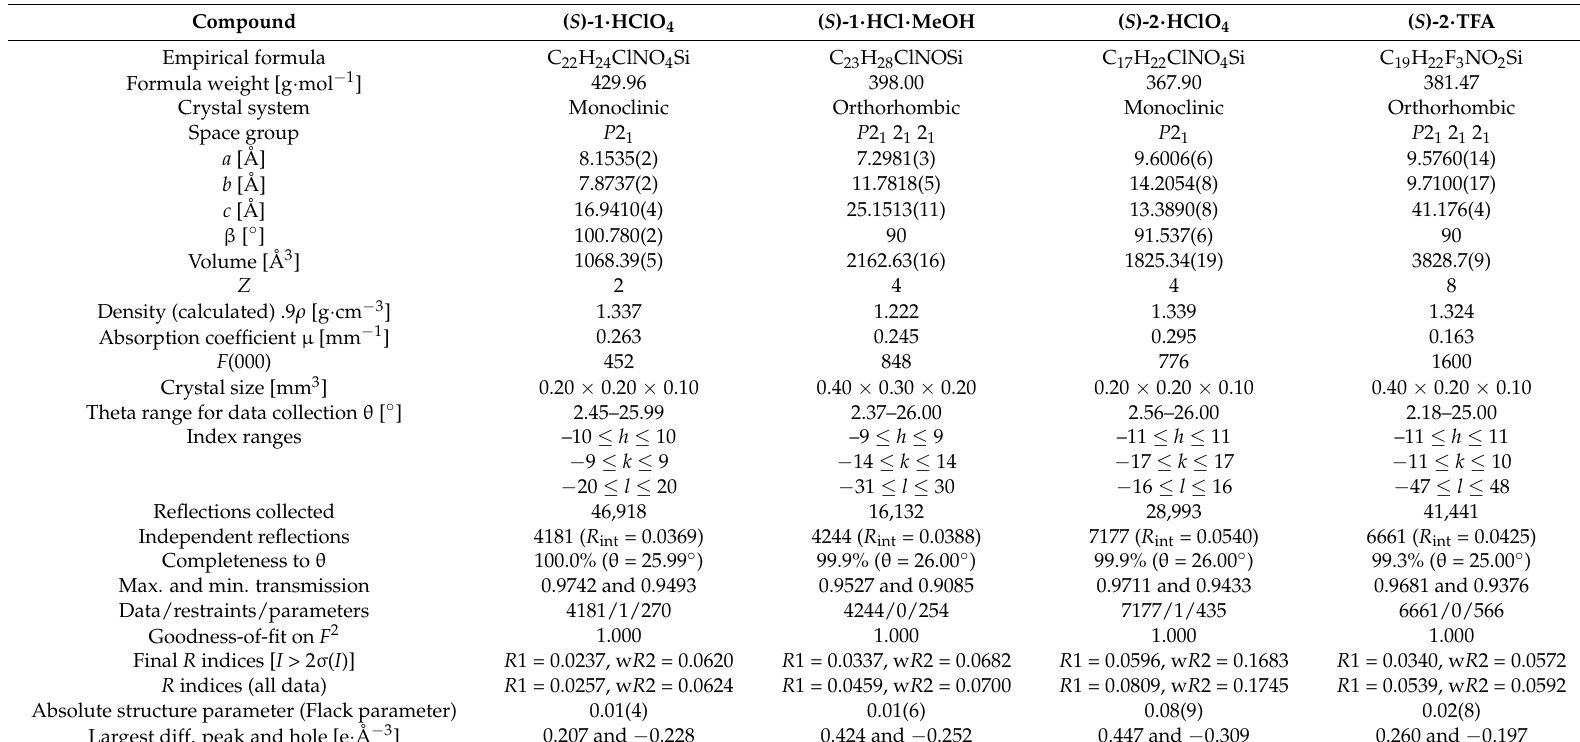
Table 1. Crystal data and structure refinement of compounds ( S )- 1 · HClO 4 , ( S )- 1 · HCl · MeOH, ( S )- 2 · HClO 4 , and ( S )- 2 ·